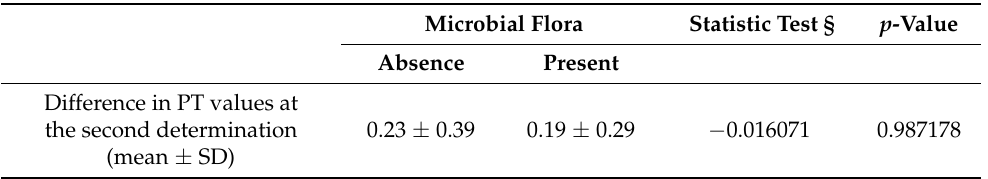
Table 5. Accidental presence of clot in erythrocyte sediment interferes with determination of PT test. Quantitative evaluation of PT test changes in the presence of clot in erythrocyte sediment. Clot Absent Clot Present p -Value ( n = 526) ( n = 18) Changes in prothrombin time (PT) no changes, n (%) 81 (15.4%) 11 (61.1%) 0.00002 * present changes, n (%) 445 (84.6%) 7 (38.9%) PT values in the second determination Unchanged, n (%) 81 (15.4%) 11 (61.1%) 0.00001 *Decrease, n (%) 98 (18.6%) 4 (22.2%) Growth, n (%) 347 (65.9%) 3 (16.7%) Yates Chi-square test, (*) Marked effects are significant at p <